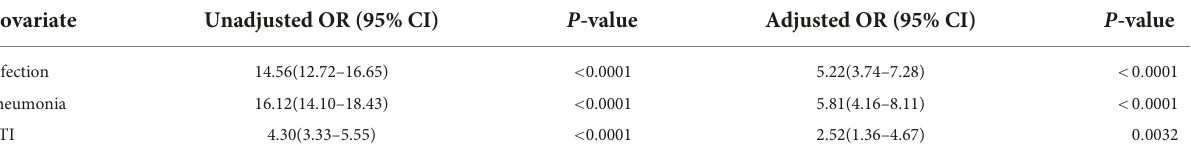
TABLE 5 Association between post-stroke infection and in-hospital mortality.